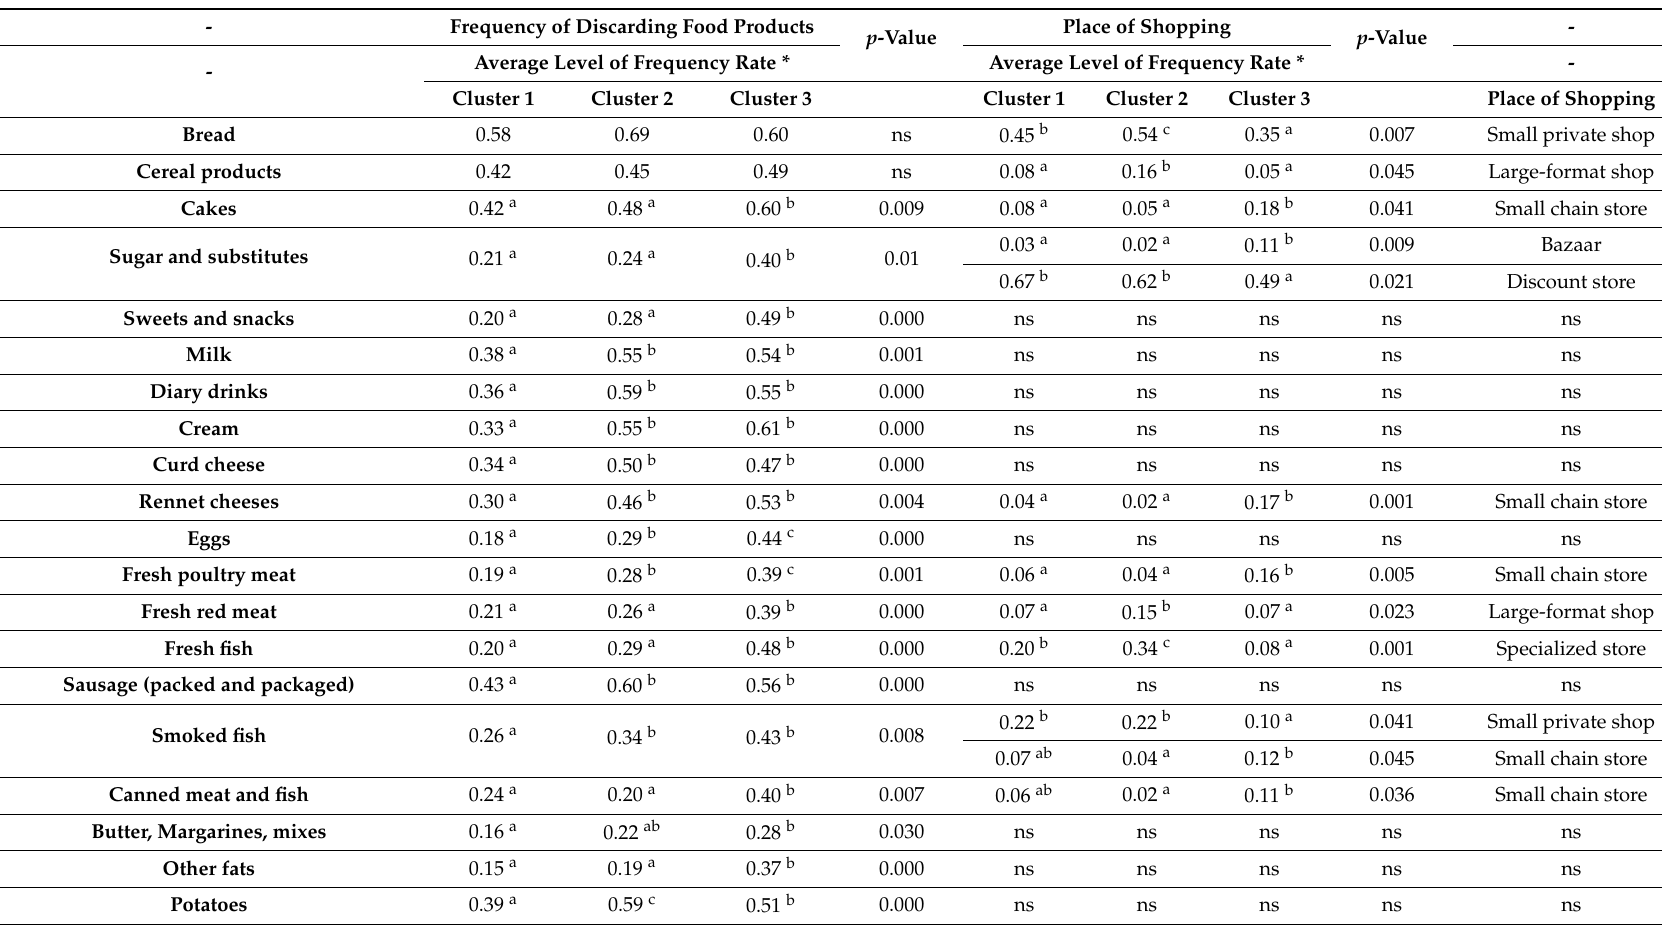
Table 4. Frequency of discarding 32 groups of food products and place of purchase, average level of frequency rate for the designated clusters, and the results of the variance analysis and the LSD